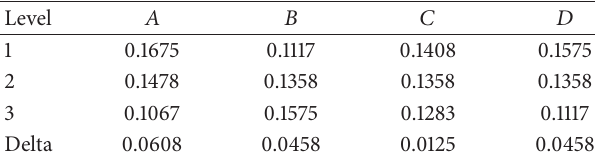
Table 5: Means response table for